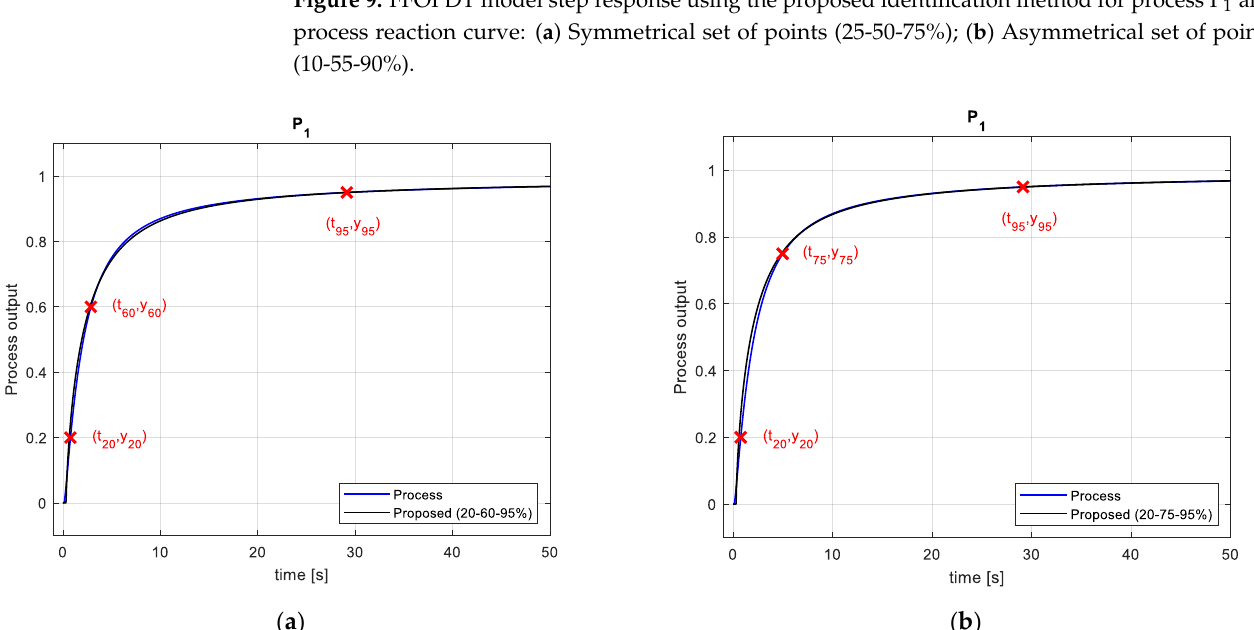
Figure 10. FFOPDT model step response using the proposed identification method for process P 1 and process reaction curve: ( a ) Asymmetrical set of points (20-60-95%); ( b ) Asymmetrical set of point (20-75-95%).